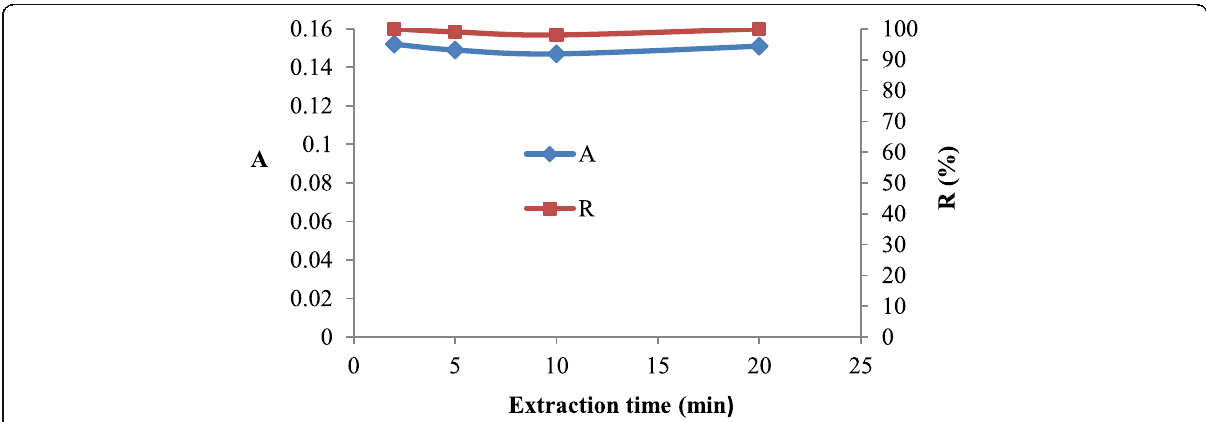
Fig. 8 Effect of extraction time on the extraction of Cu(II) ions by DLLME method. Conditions: sample volume, 10.0 mL; Cu(II), 50.0 μ g L − 1 ; salophen concentration, 2.0 × 10 − 5 M; extraction solvent (chloroform) volume, 120 μ L; disperser solvent (acetone) volume, 1.68 mL; diluting solvent (ethanol) volume, 130 μ L; centrifuge time, 5 min (at 5000